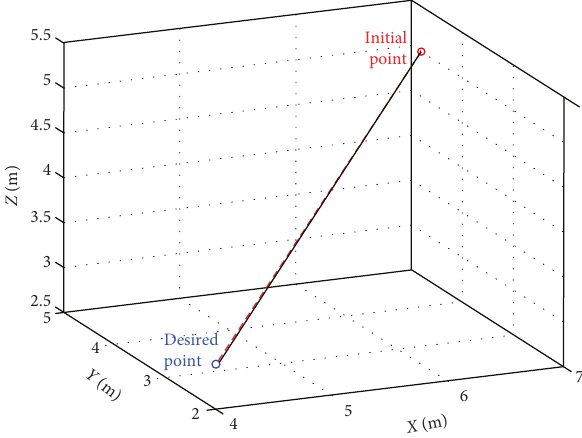
Figure 9: Comparison between the actual and the desired end- e ff ector trajectory for the combination